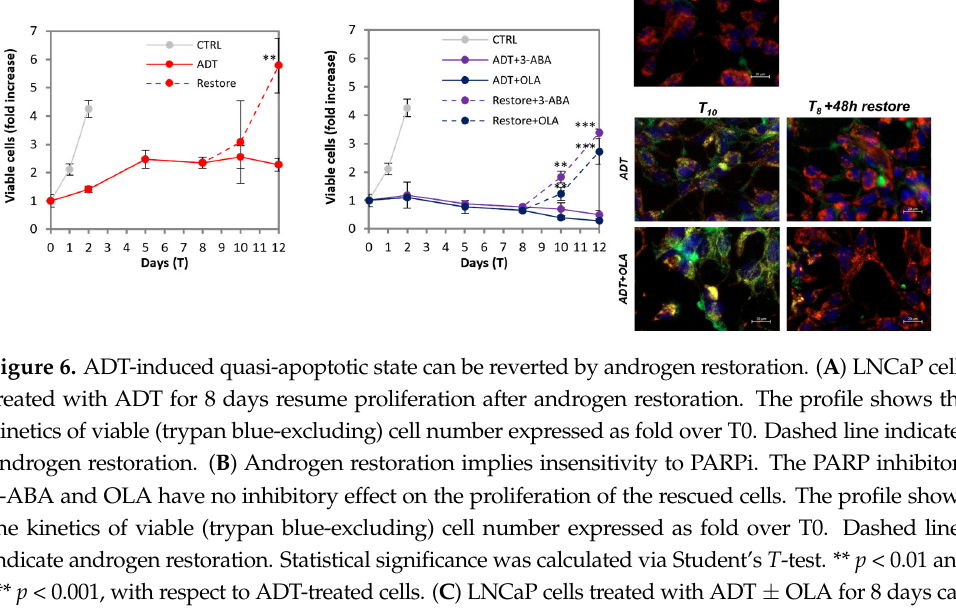
Figure 6. ADT-induced quasi-apoptotic state can be reverted by androgen restoration. ( A ) LNCaP